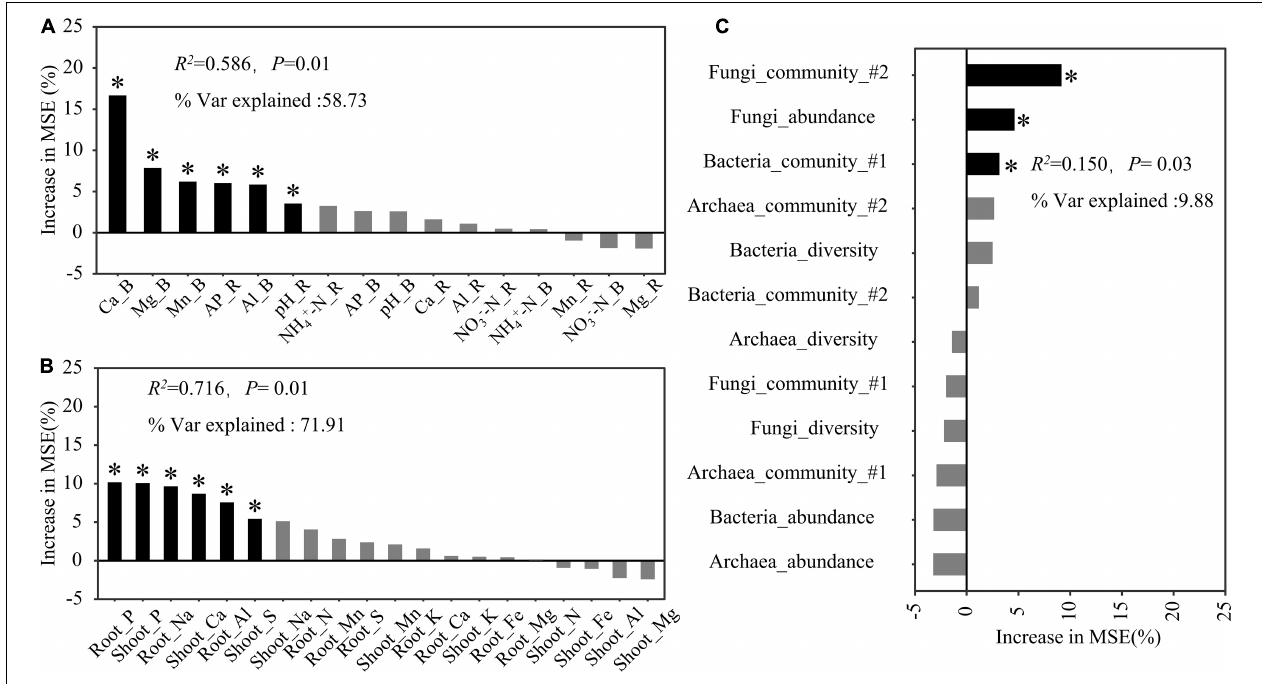
FIGURE 6 | Predicted factors, soil properties (A) , plant mineral elements (B) , and rhizosphere microbial properties (C) , contributing to the total rice biomass following a random forest regression analysis. R 2 , coefficient of determination; % Var explained, the proportion of variance explained. The microbial diversity and community used in this model were determined according to the Shannon index and the first two axes (#1 and #2) of the non-metric multidimensional scaling analysis, respectively. * Indicates factors with significant effects ( P < 0.05).